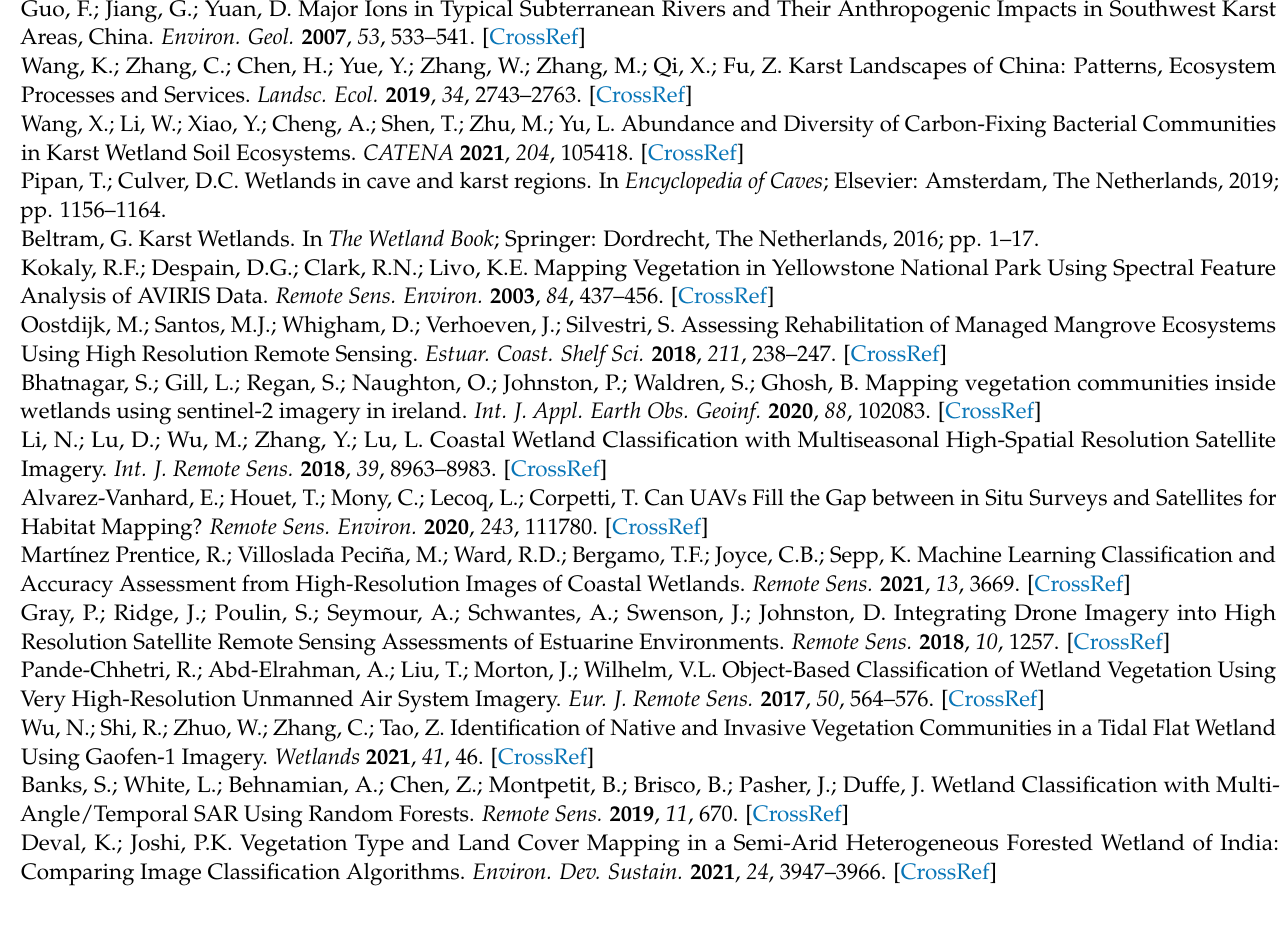
Figure A5. Training and validation curves for one-class classification of NN. ( a ) Training loss; ( b ) training accuracy; ( c ) validation loss; ( d ) validation accuracy.